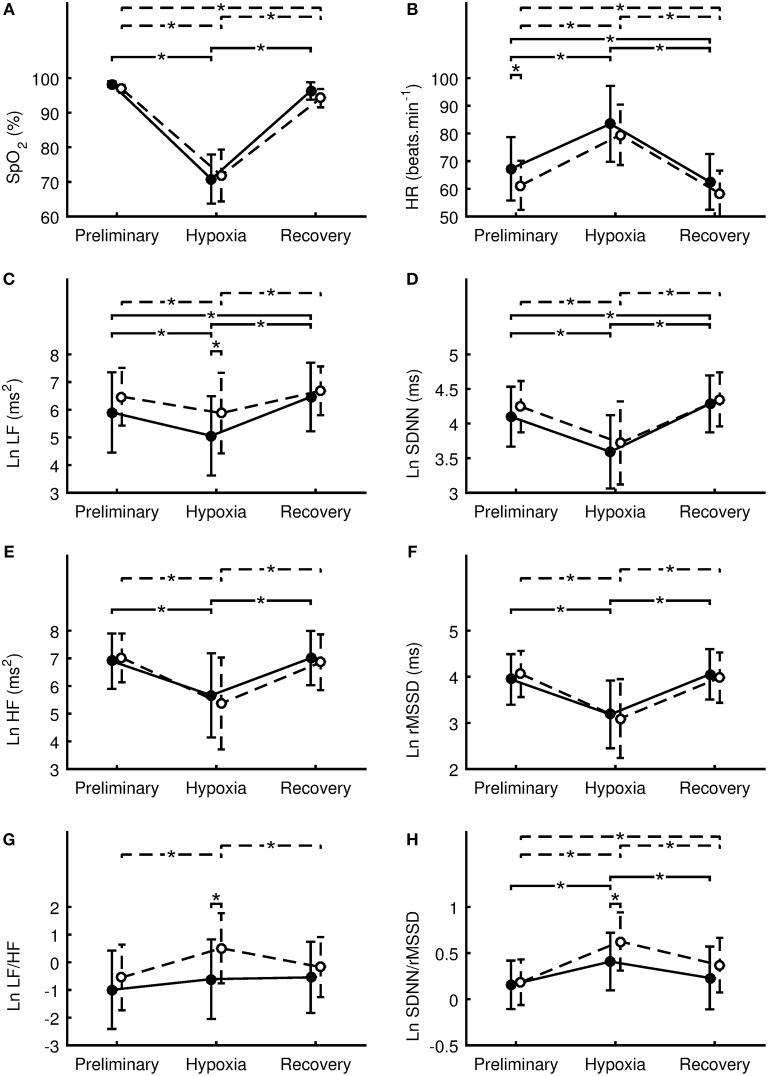
Differences between sexes in the oxygen saturation (A), heart rate (B), natural logarithm of low frequency power (C), natural logarithm of standard deviation of RR intervals (D), natural logarithm of high-frequency power (E), natural logarithm of square root of the mean of the squares of the successive differences (F), natural logarithm of ratio of low-frequency to high-frequency power (G), natural logarithm of ratio of SDNN to rMSSD (H). Values of females are denoted by filled circles and solid line. Values of males are denoted by open circles and dashed line. Values are presented as the mean ± standard deviation. Comparisons were performed by means of Fisher's LSD post-hoc test and only significant differences are displayed: *p < 0.05.